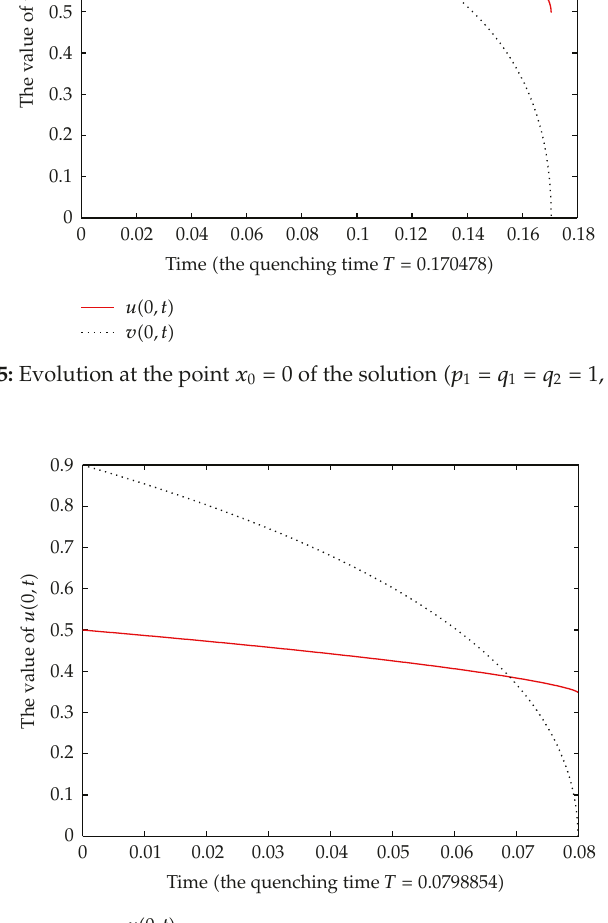
where { ψ k } is the standard base of V h . Then (cid:5) U (cid:5) t (cid:6) , v (cid:5) t (cid:6)(cid:6) satisfies the following ODE